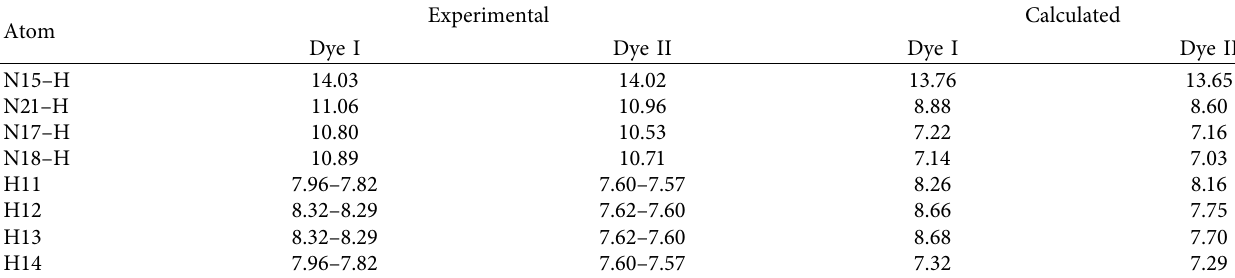
6 and for imine-diketo-hydrazone forms (T-V) calculated